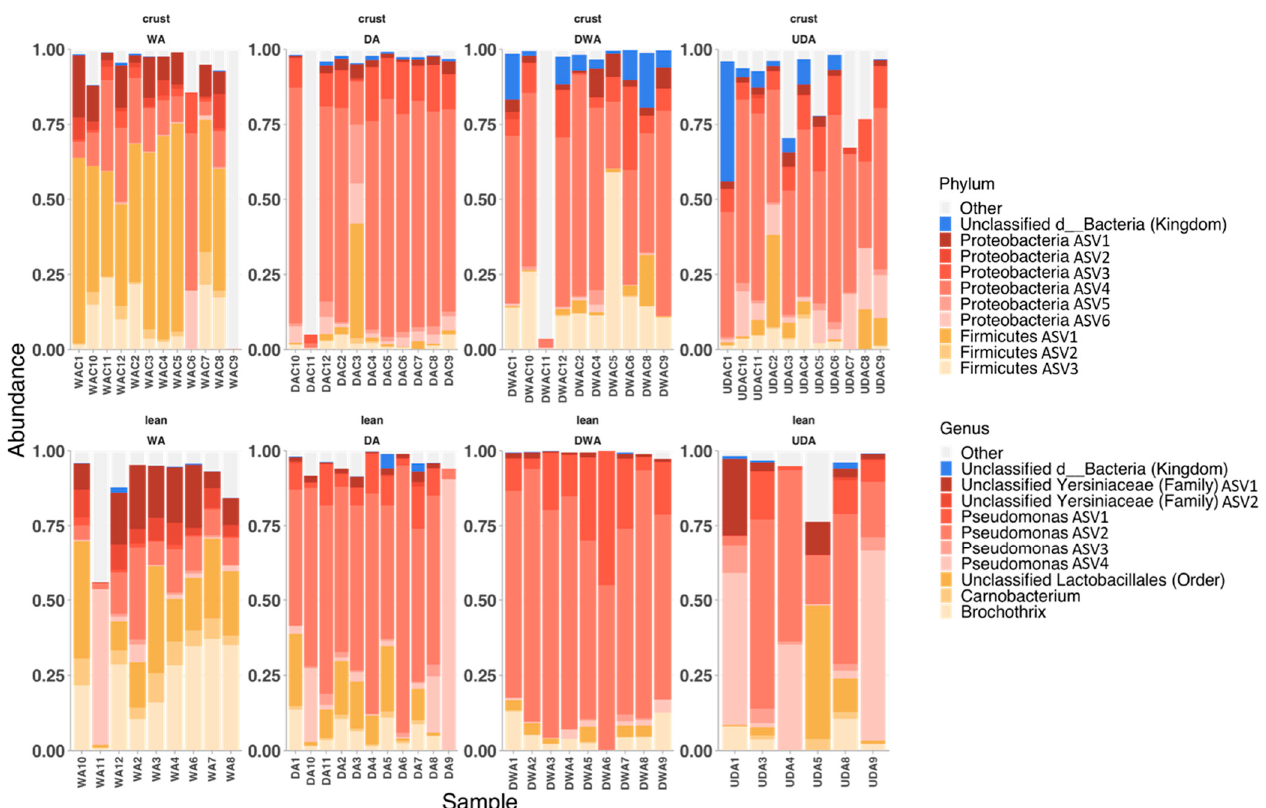
Figure 2. Relative abundances of the top 10 bacterial ASVs from cull cow beef loins ( M. longissimus lumborum ) aged with different aging methods (wet aging (WA), dry-aging (DA), dry-aging in a water-permeable bag (DWA), and UV-light dry-aging (UDA)). Amplicon sequence variant (ASV) identifications at both phylum and genus levels are indicated. For example, Pseudomonas ASV1 is classified as Proteobacteria at the phylum level.